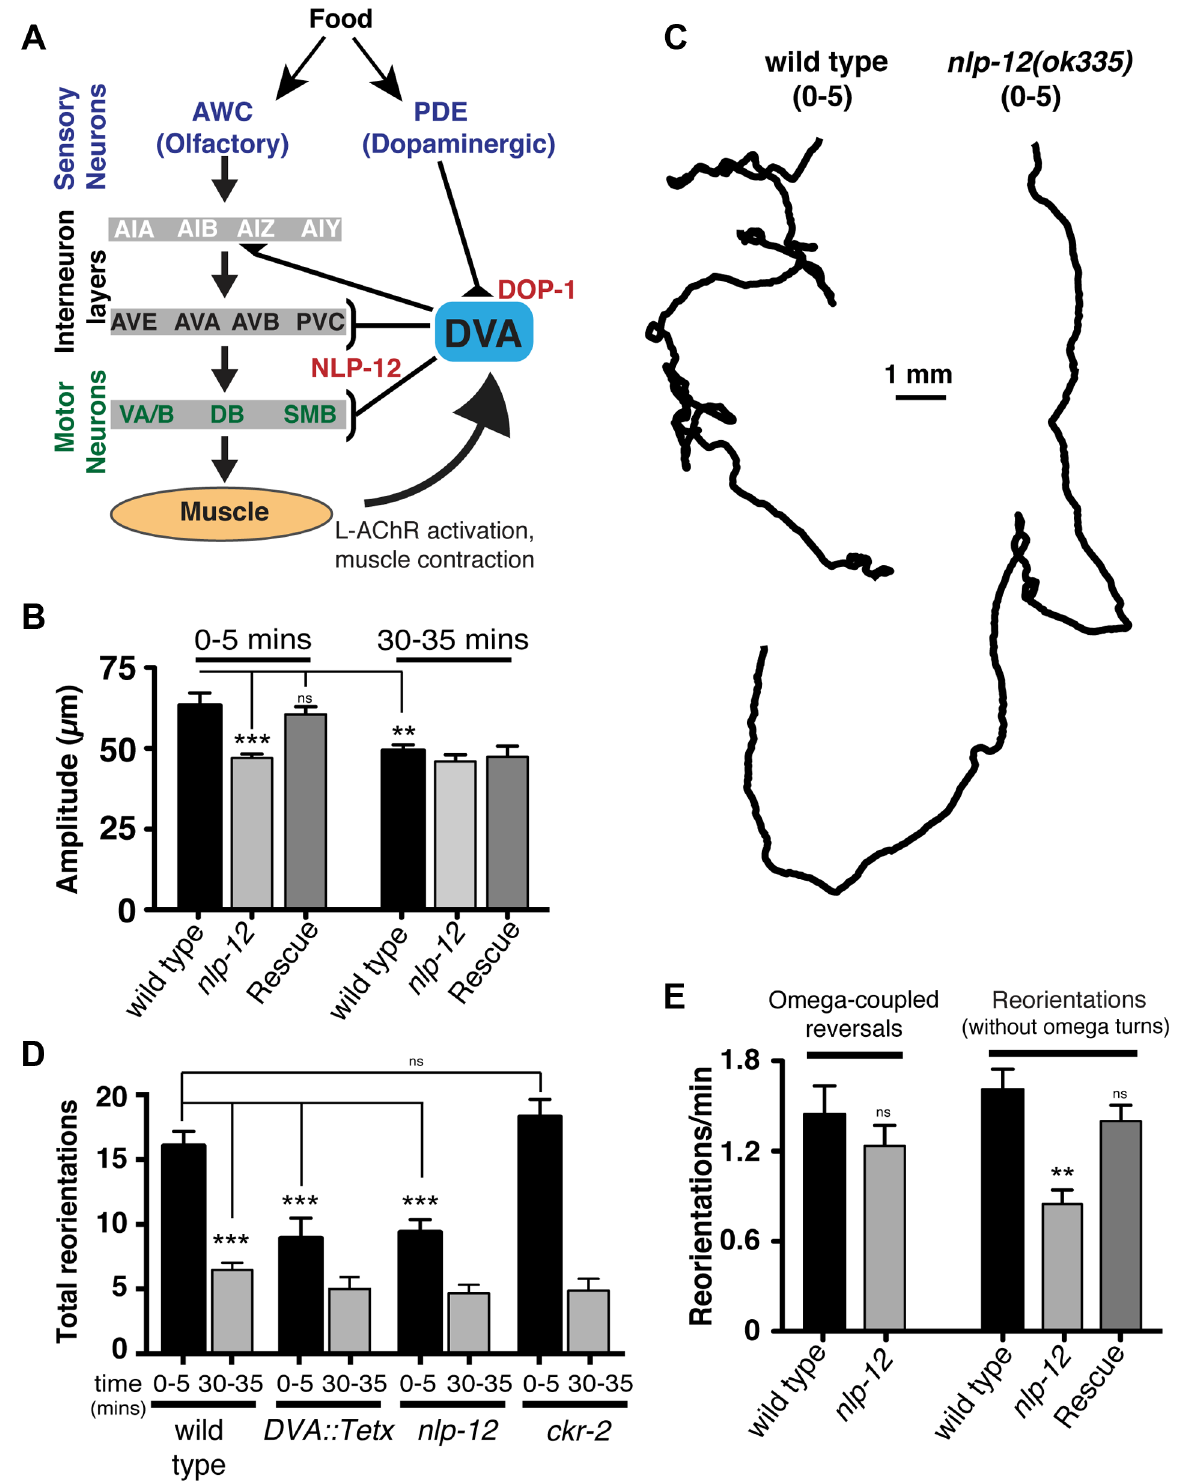
Figure 3. Modulation of body bend depth through NLP-12/CCK signaling is critical for local food searching. ( A ) Schematic representation of the neural circuit underlying NLP-12 modulation of local searching. Synaptic connections (triangles, brackets) are as described by [42]. DVA receives synaptic input from the dopaminergic neuron PDE and makes connections with both motor neurons and interneurons involved in locomotory control. DVA makes synaptic contacts onto all of the motor and interneurons indicated by brackets. In addition, DVA is connected to AVB and PVC by gap junctions. Assignments of interneurons into layers are as described by [13]. Other neuron classes are as described in the text and references therein. DOP-1 modulation of DVA activity regulates NLP-12 release from DVA, altering the motor pattern during local food searching. ( B ) Average body bend amplitude for the genotypes as indicated measured during an initial five minute time interval (0–5) immediately following